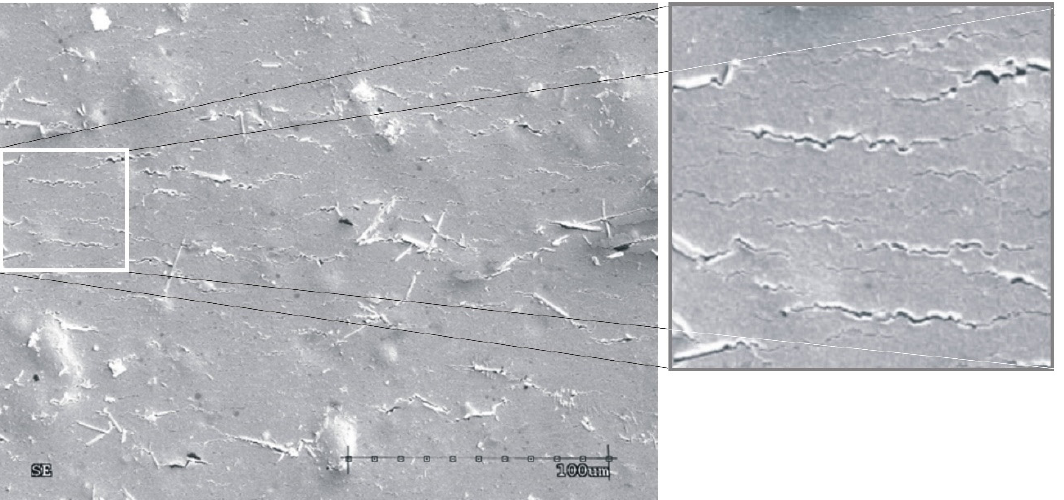
Figure 1. The microscopic image of created metallic layer under physical vacuum deposition (the dimensions of the enlarged box 150 × 150 µm).